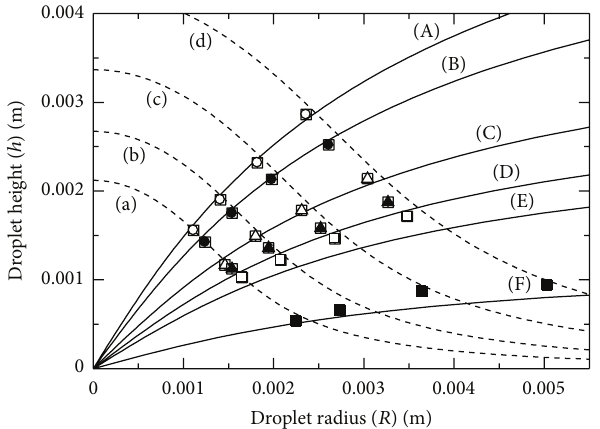
Figure 4: Relationship between droplet height and radius: (a) 5, (b) 10,(c)20,and(d)40 𝜇 Lareanalyticalsolutions;(A)0.0718,(B)0.057, (C)0.0384,(D)0.0312,(E)0.0274,and(F)0.0211 J m −2 aretheoretical lines.